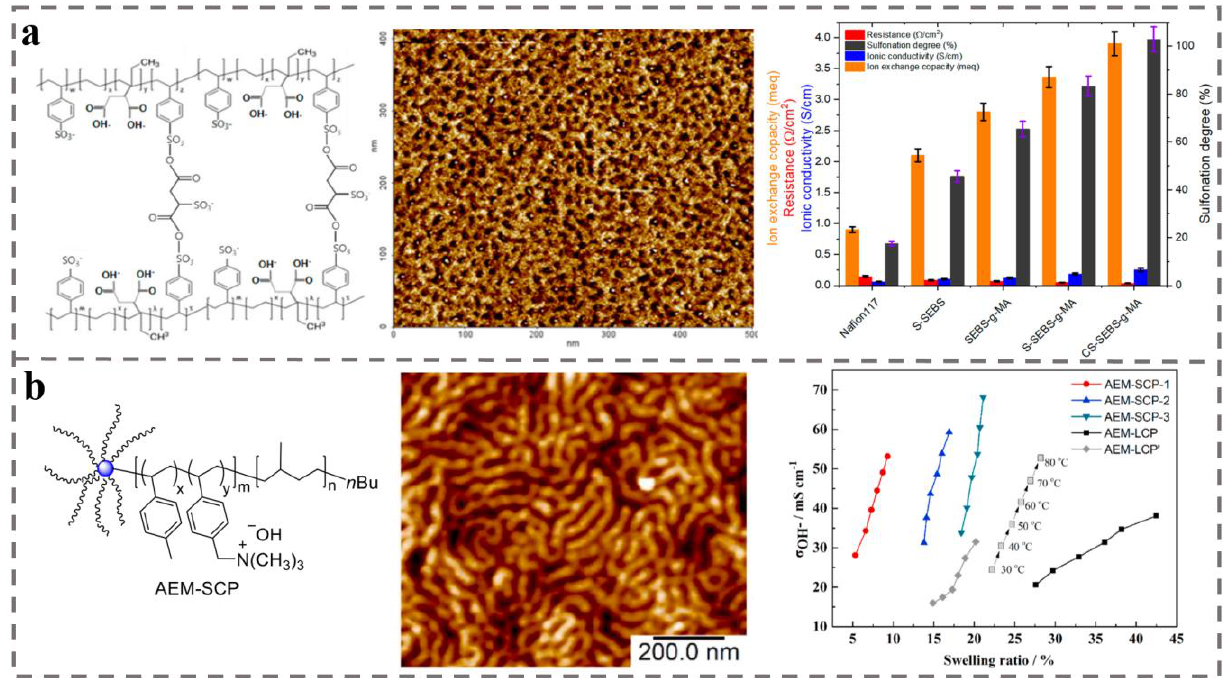
Figure 10. ( a ) Molecular structure formula of S-SEBS-g-MA AEM and its AFM phase image. Com- pared with AEM formed by grafting different molecular chains and Nafion 117, S-SEBS-g-MA AEM has the superior ionic conductivity and IEC performance [209]. ( b ) Molecular structure and AFM image of AEM-SCP membrane and its anion conductivity versus swelling ratio [212].